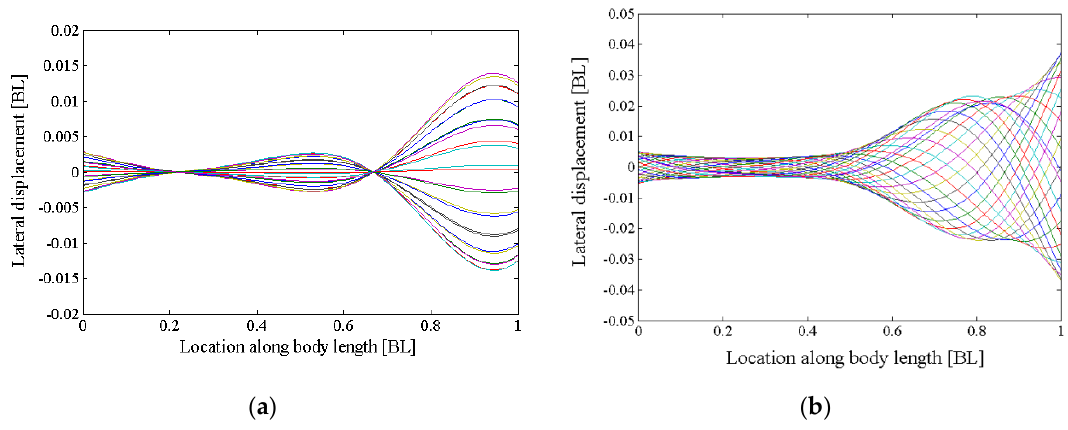
Figure 9. The separated standing and travelling parts of the midline motion of the carangiform fish. ( a ) standing part; ( b ) travelling part.